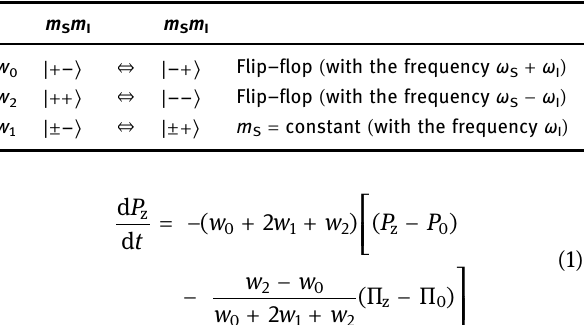
Table 1: Chart of determination of transition probabilities via